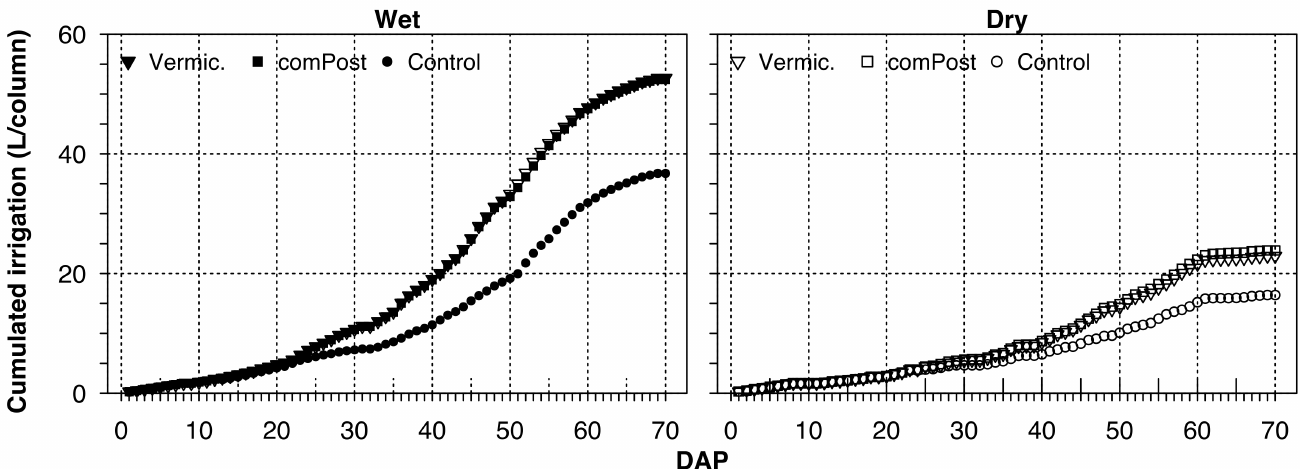
Figure 2. Cumulated amount of irrigation water (L of water per column), during all the experiment (1 to 70 DAP). Values are means ( n = 5) and error bars represent the standard deviation, but they were not presented as they were smaller than the